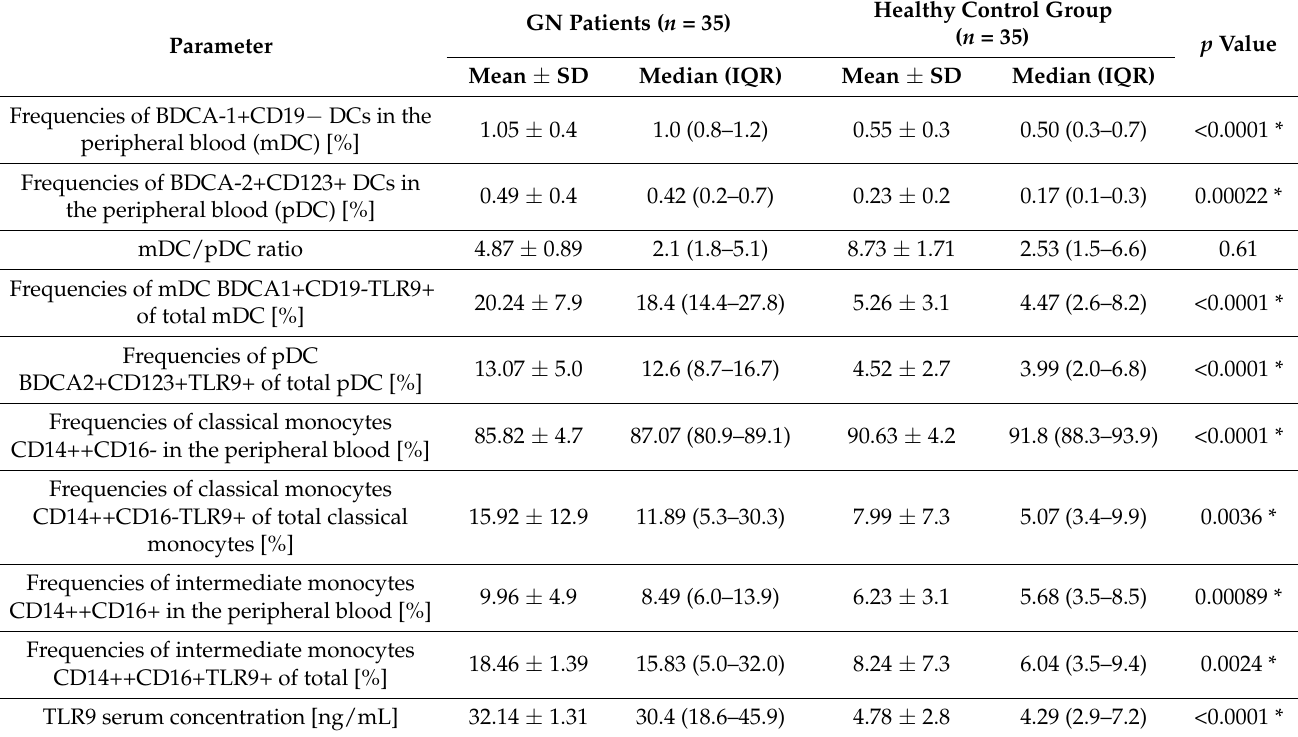
Table 3. Frequencies of TLR9-positive DCs and monocytes among patients from the research group and the control